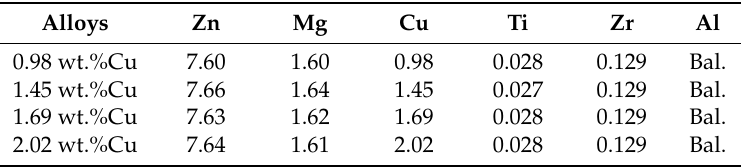
Table 1. The chemical compositions of alloys